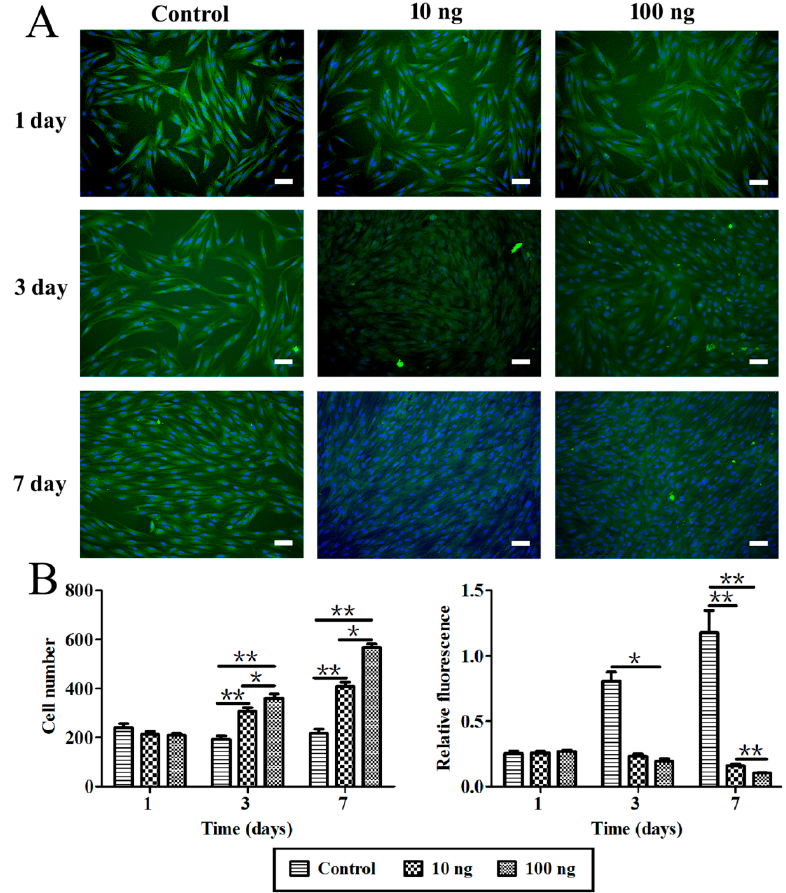
Figure 5. Observation and analysis of BMSCs in vitro by high content screening. ( A ) The immunofluorescence image of BMSCs, scale bar is 100 µ m; ( B ) The cell number of BMSCs content by nucleus and the calculated mean intensity of collagen type II according to the number of DAPI-stained cells. 10 ng means 10 ng/mL; 100 ng means 100 ng/mL BMP3 in the culture media; control, without BMP3. Mean ± SD, n = 3; * p < 0.05, ** p < 0.01.